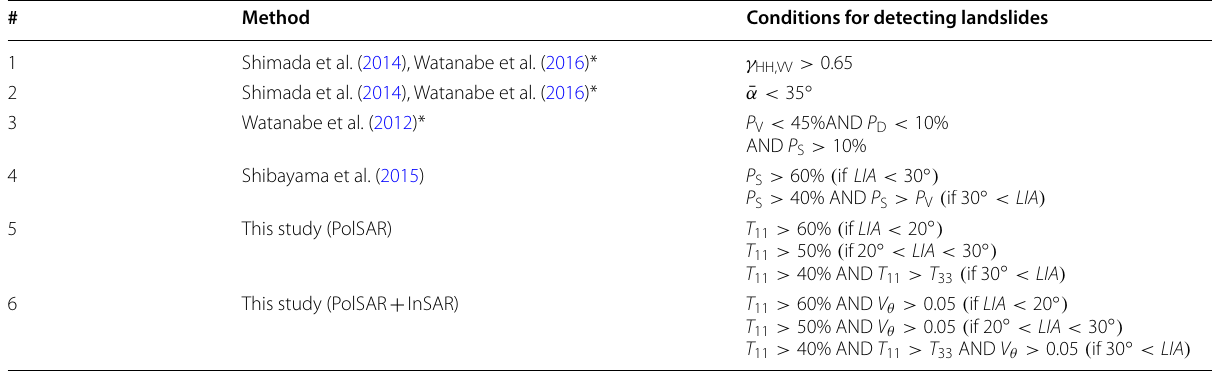
Table 2 Landslide detection methods based on empirical rules compared in this